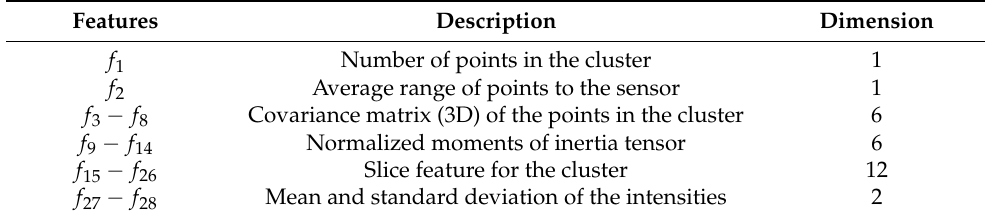
Table 1. Features of a cluster for pedestrian classification. Features Description Dimension f 1 Number of points in the cluster 1 f 2 Average range of points to the sensor 1 f 3 − f 8 Covariance matrix (3D) of the points in the cluster 6 f 9 − f 14 Normalized moments of inertia tensor 6 f 15 − f 26 Slice feature for the cluster 12 f 27 − f 28 Mean and standard deviation of the intensities